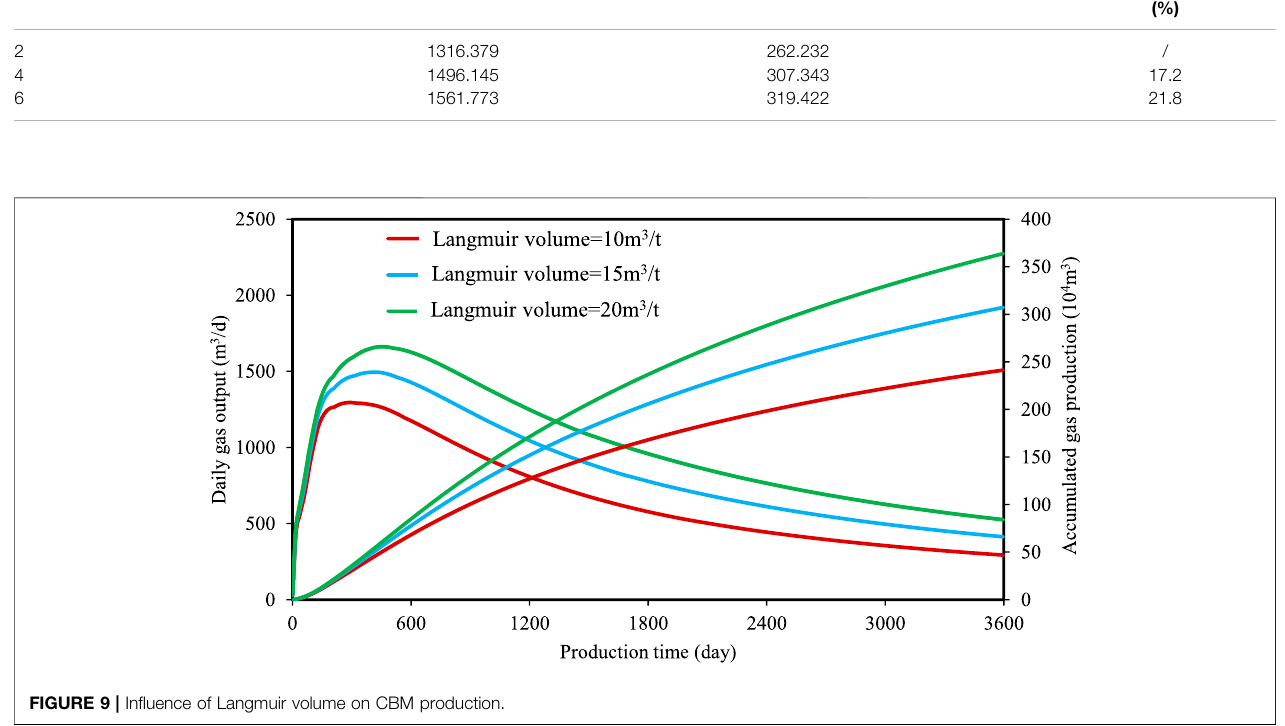
TABLE 6 | Effect of Langmuir volume on